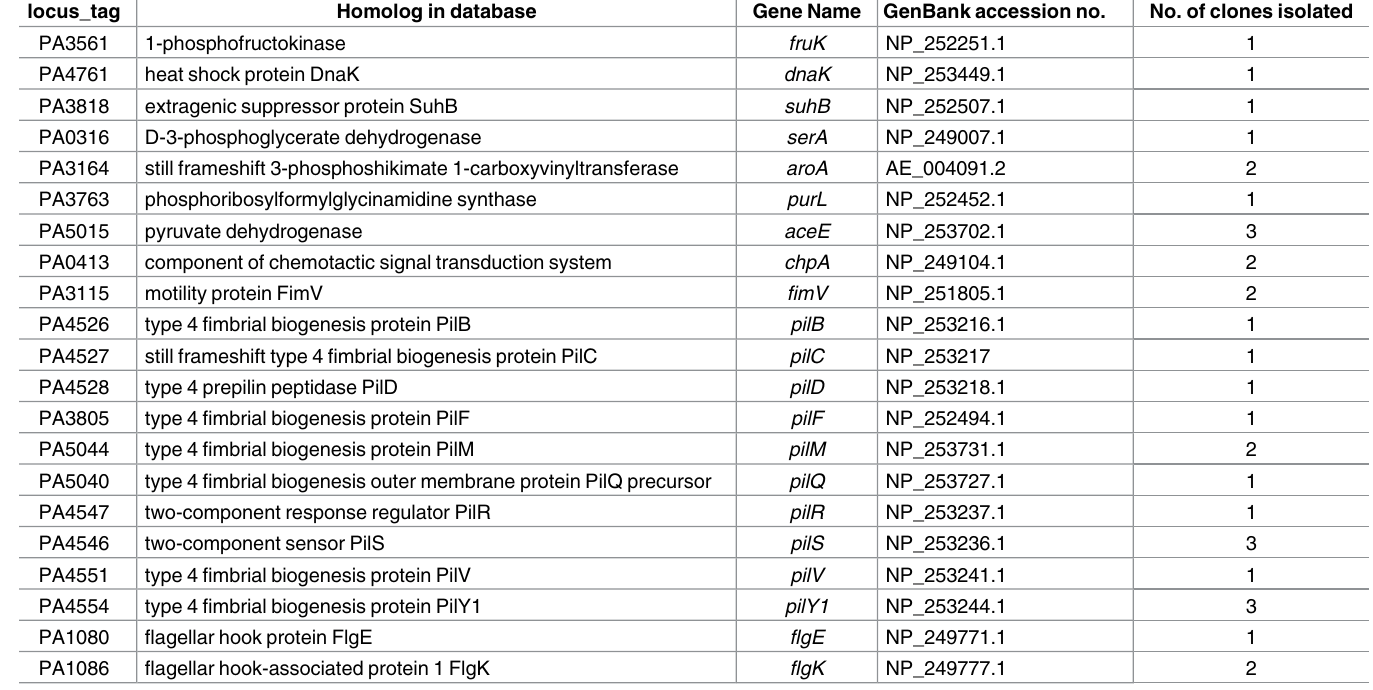
Table 3. Specification of genes responsible for penetration